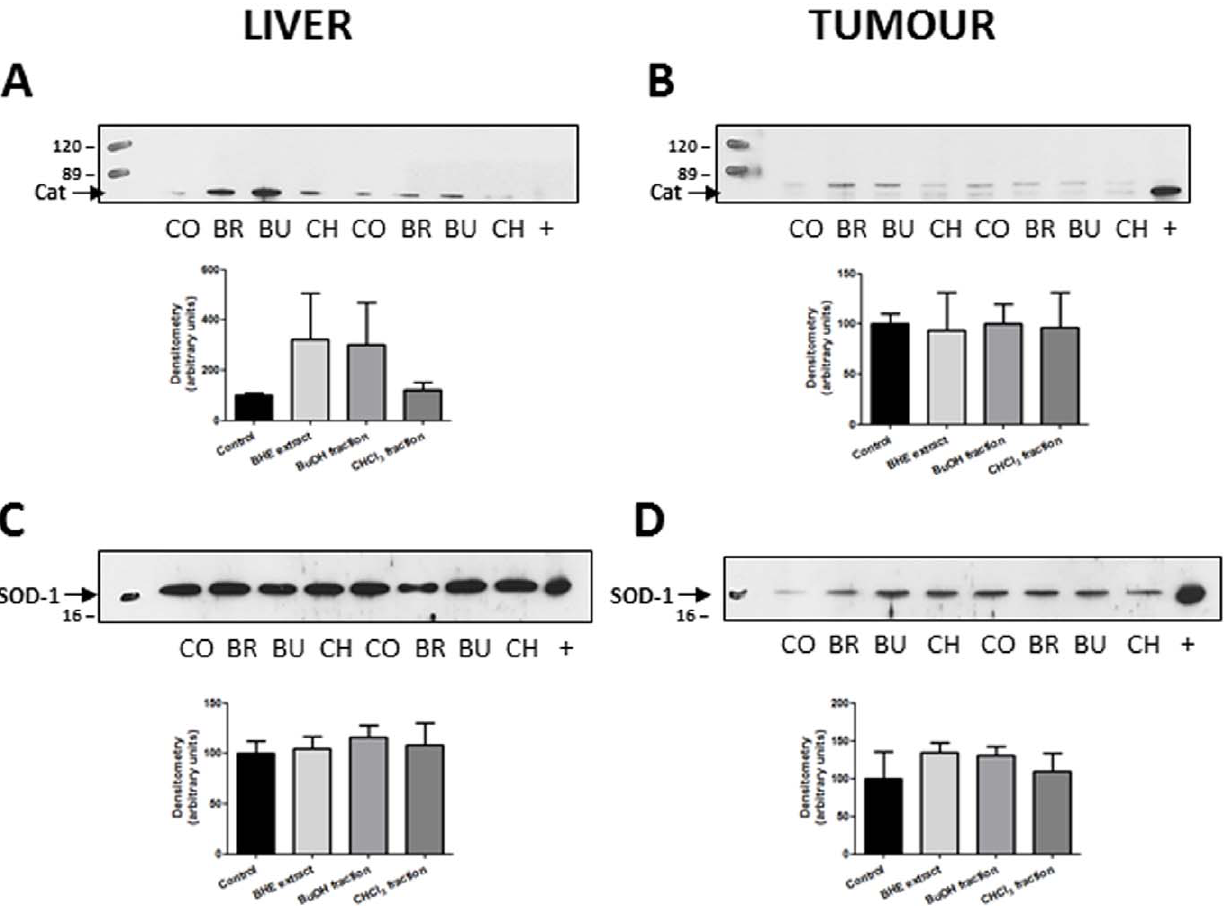
Figure 6. Catalase expression in liver (A) and tumour (B), and SOD-1 expression in liver (C) and tumour (D), as measured by Western blot. The densitometry graphs are displayed beside each picture. Group abbreviations: CO: Control, BR: BHE extract, BU: BuOH fraction, CH: CHCl 3 fraction. doi:10.1371/journal.pone.0054618.g006 PLOS ONE |